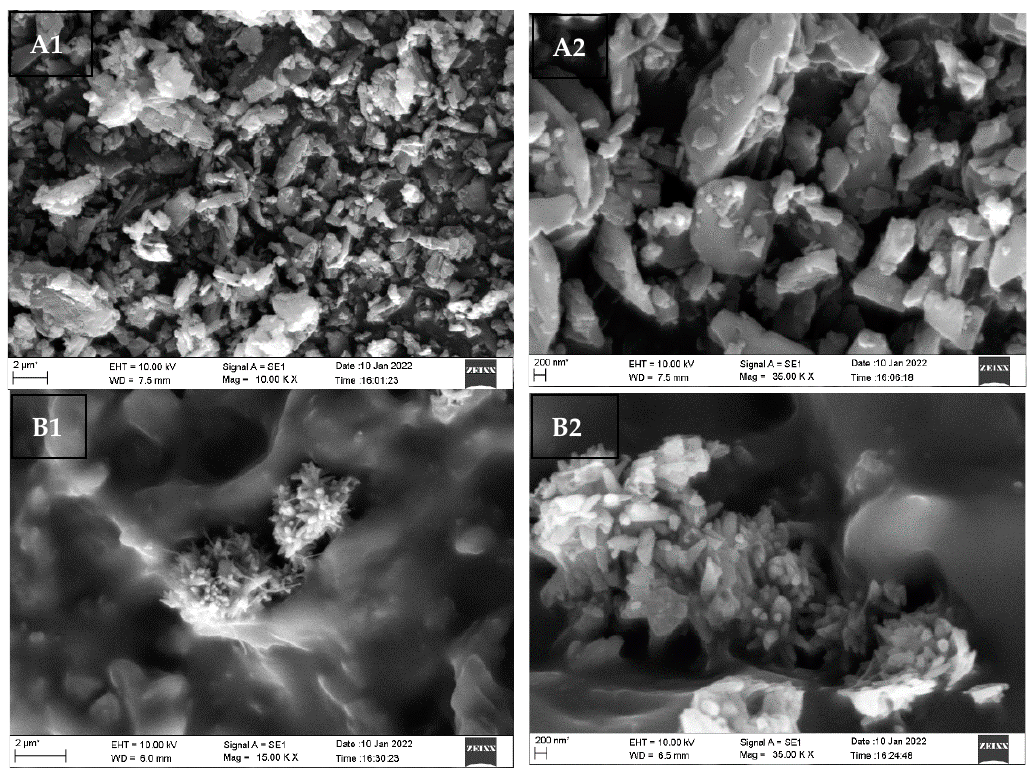
Figure 6. Scanning Electron Microscopy images of SIL and H6-SNP. ( A1 ) and ( A2 ) represent SIL images at 2 µm and 200 nm scale; ( B1 ) and ( B2 ) represent the H6-SNP images at 2 µm and 200 nm scale.